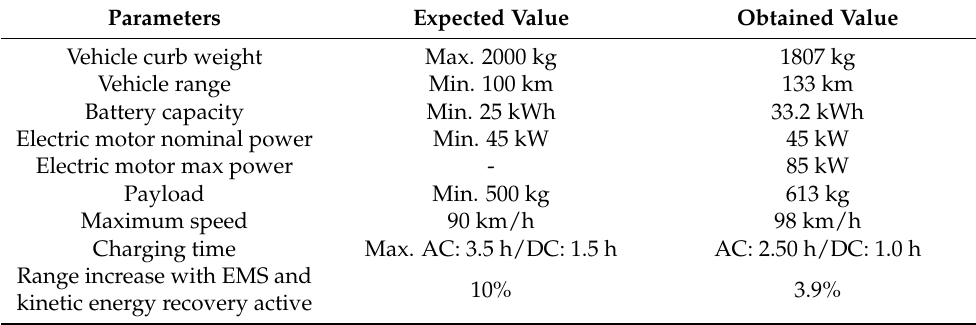
Table 1. Prototype vehicle specification.